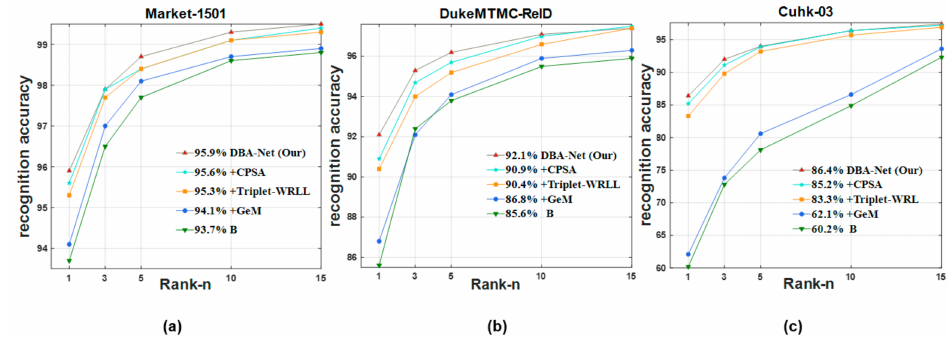
Figure 14. CMC curves of DBA-Net on three datasets. ( a ) The Market-1501 dataset. ( b ) The DukeMTMC- ReID dataset. ( c ) The Cuhk-03 dataset.